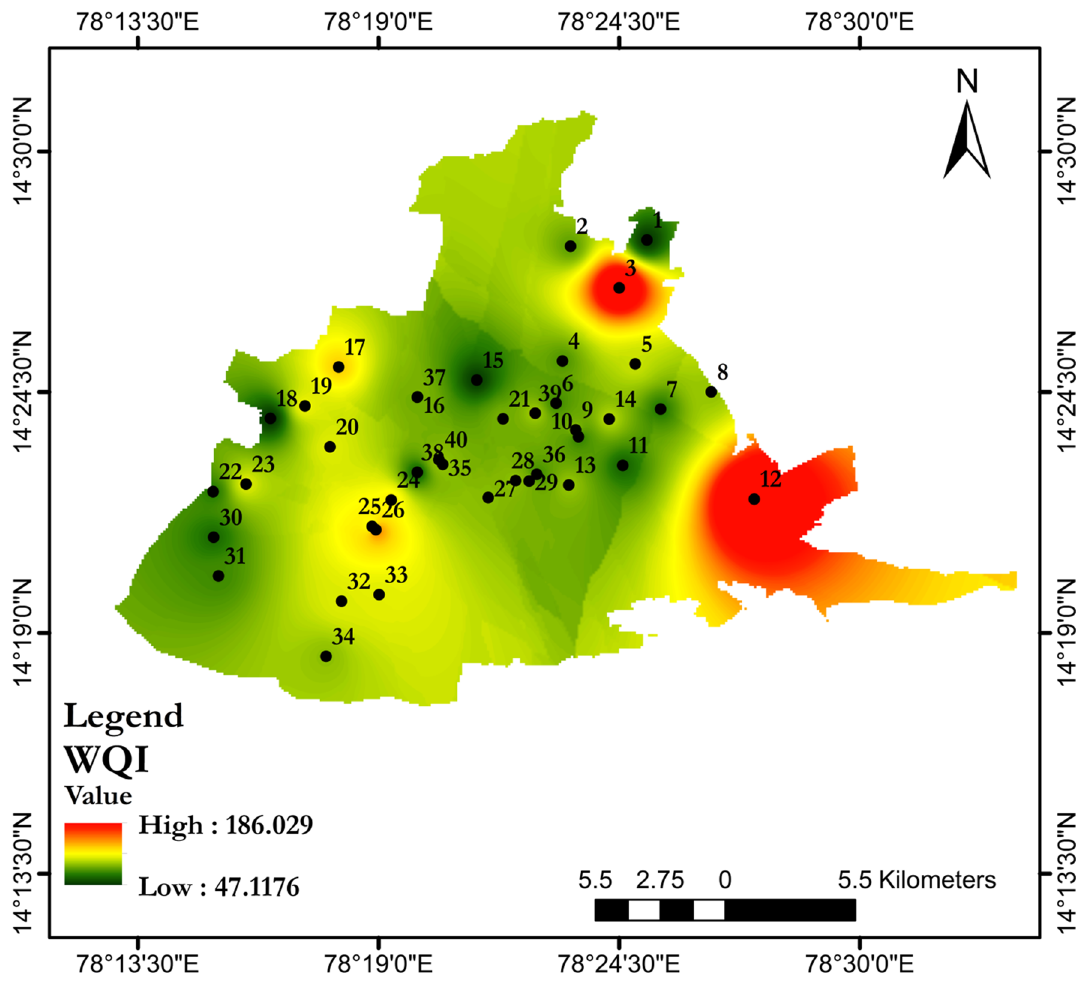
Fig. 9 Spatial distribution map of water quality